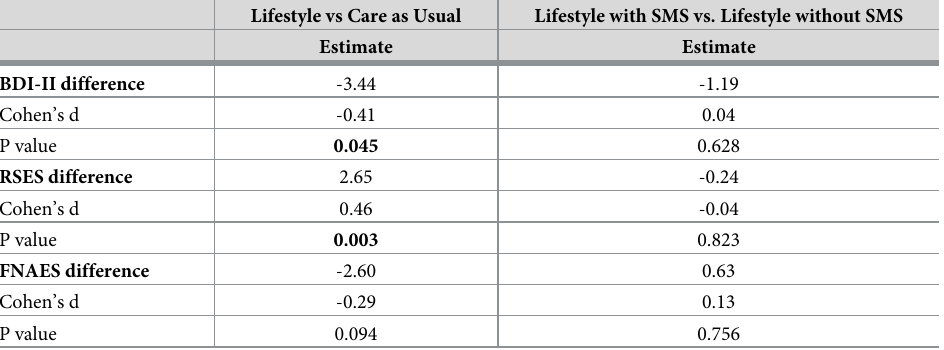
Table 2. Difference in depression, self-esteem and body image changes between study groups at 12 months. The difference in depression, self-esteem and body image scores over time compared between lifestyle and care as usual and compared between lifestyle with SMS and without SMS. Cohen’s D 0.20 is small effect, 0.50 is medium effect and 0.80 a large effect, BDI-II = depression, RSES = self-esteem, FNAES = body